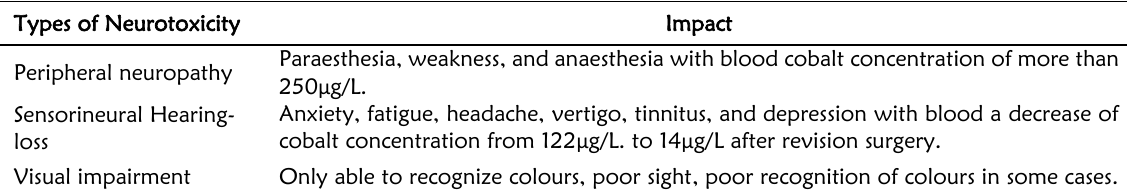
Table 2: Types of neurotoxicity and their impact on individuals